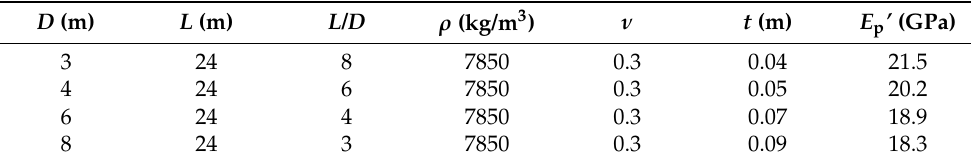
Table 4. Parameters of scour holes.